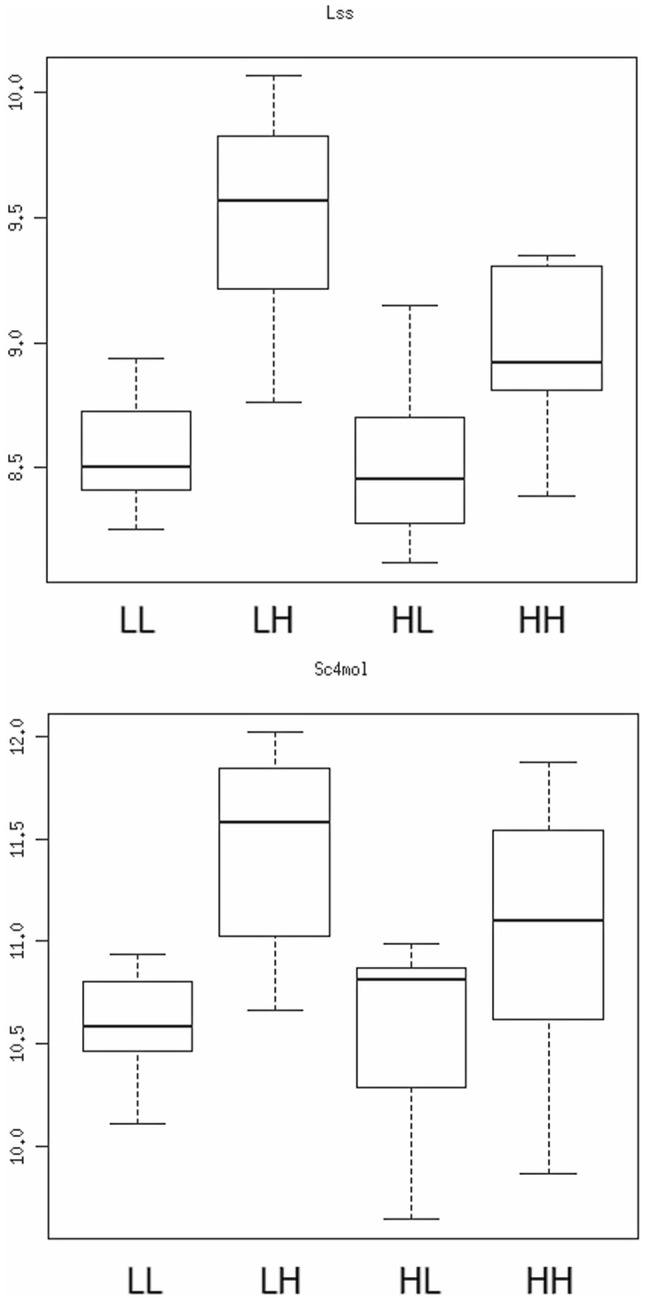
Expression level of two cholesterol synthesis genes in the liver of 9-week-old male offspring according to their maternal and post-weaning diets.The graph shows the normalized probe intensity measured for Lanosterol synthase (Lss, top panel) and Sterol-C4-methyl oxidase–like (Sc4mol, bottom panel) for all 40 samples. The dams' diet is indicated before the underscore, the post-weaning diet after it (the group order is identical to that of Figure 1). LF stands for low fat diet, HF for high fat diet. The thick line represents the median value of each group, the box delineates the 75th percentiles, and the whiskers the 95th percentiles.